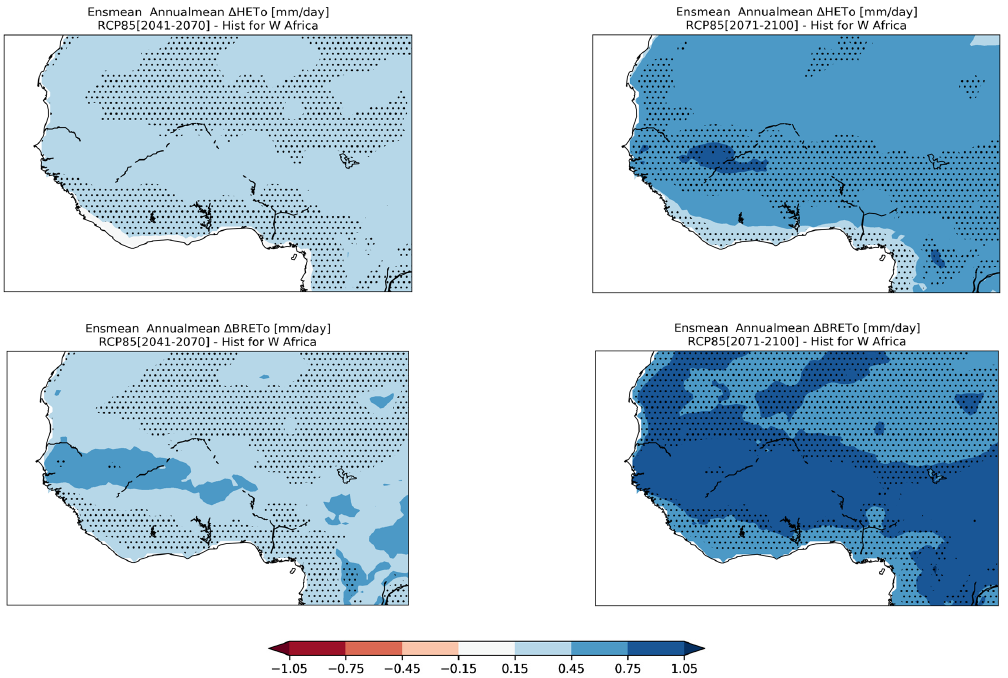
Figure 3. Projected changes in crop water demand (mm/day) for mid-future ( left column) and far future ( right column) computed using HETo ( top panel) and BRETo ( bottom panel) methods from the ensemble mean of regional climate models derived under RCP 8.5.